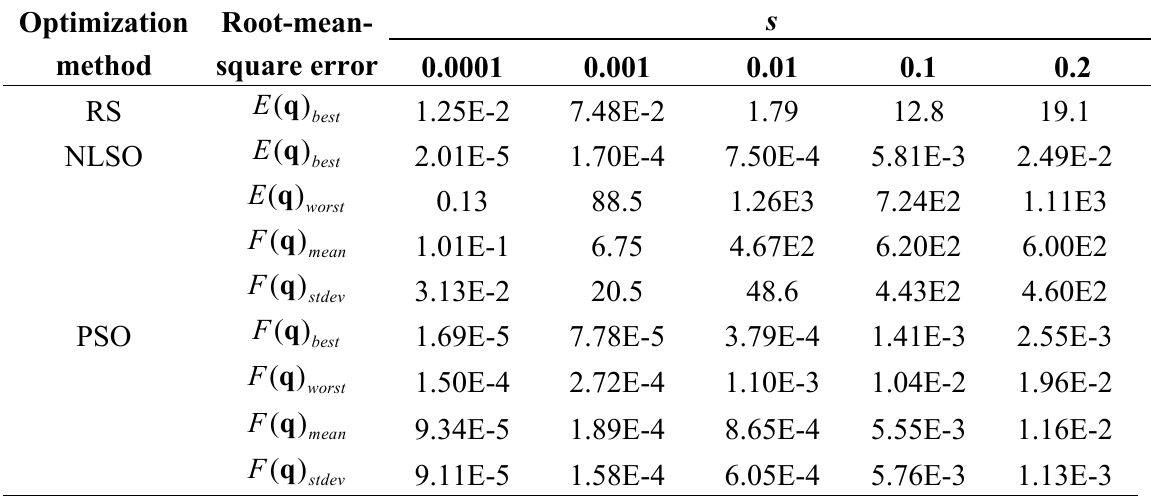
Table 1. Estimation results with 50 sets of simulation data and with a different number of evaluations: 1,000,000 evaluations for RS, 1,000 runs for NLSO, and 10 runs for PSO.